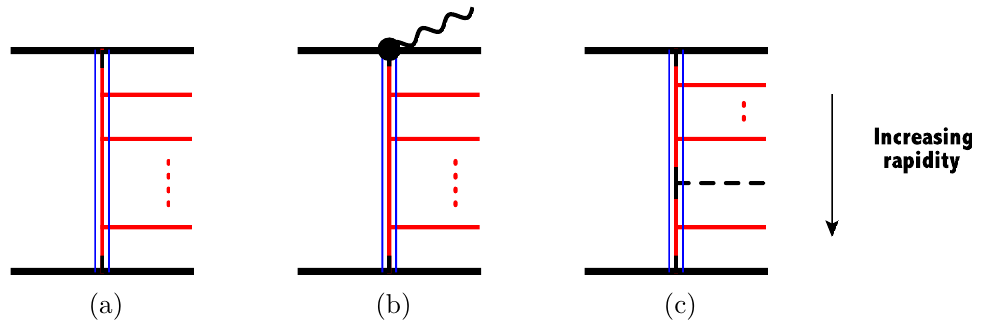
Figure 6. These diagrams illustrate the schematic structure of an amplitude in HEJ (eq. (2.16)) for (a) pure jets, (b) W plus jets and (c) Higgs boson plus jets. The black thick lines represent the skeleton or Born process in each case, described by the function B . The external red lines represent the production of resolved real gluons, each with a factor V . The blue lines indicate the range of rapidity over which the virtual corrections are applied, which are encoded in the W factors. Dotted red lines indicate that the number of additional gluons is not fixed and the dashed black line in (c) indicates the Higgs